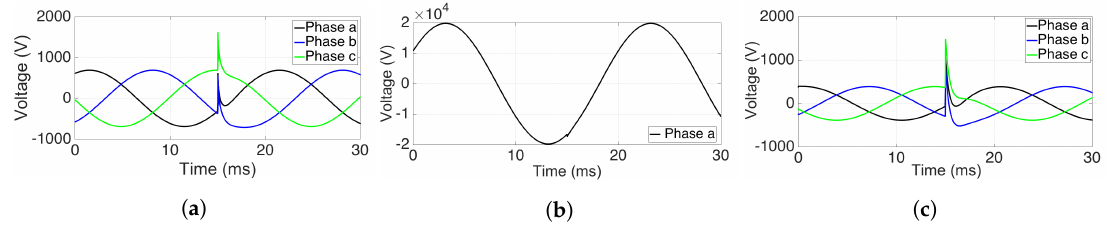
Figure 6. Impact of high frequency SA on transient overvoltages. ( a ) LV side of the main transformer; ( b ) HV side of the main transformer from node to ground; ( c ) control circuits.